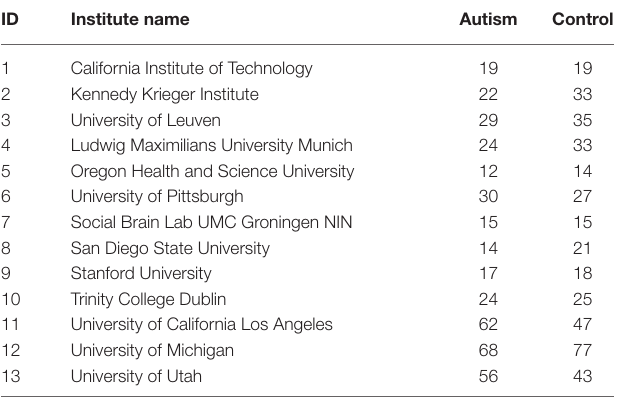
TABLE 1 | Institute names used in our study from ABIDE data and subject distribution by diagnosis code, Autism and Control.